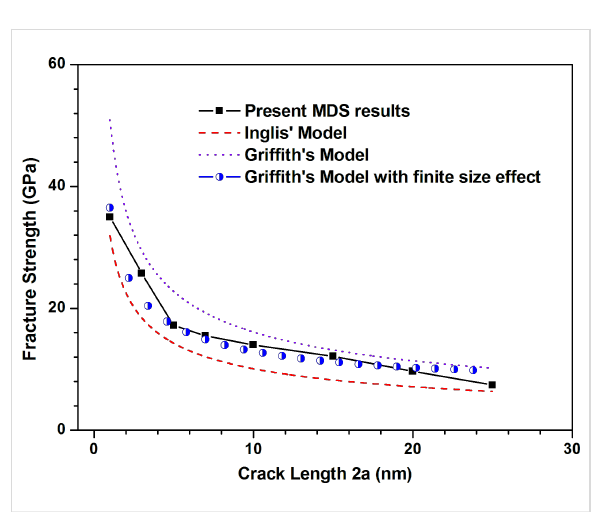
Figure 12: Comparison of fracture strength of MoS 2 sheet between MDS results and three continuum fracture mechanics models versus different crack